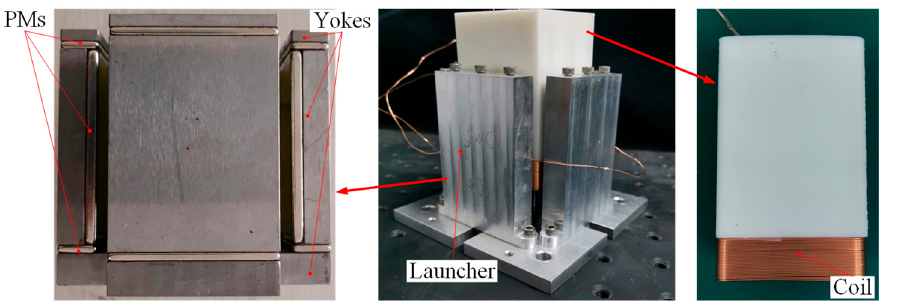
Figure 14. Prototype of the launcher.